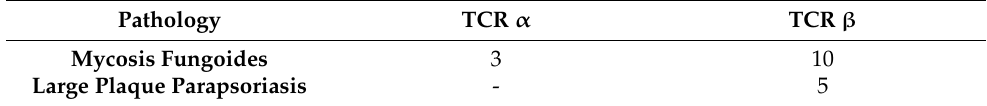
Table 5. TCR assessment by